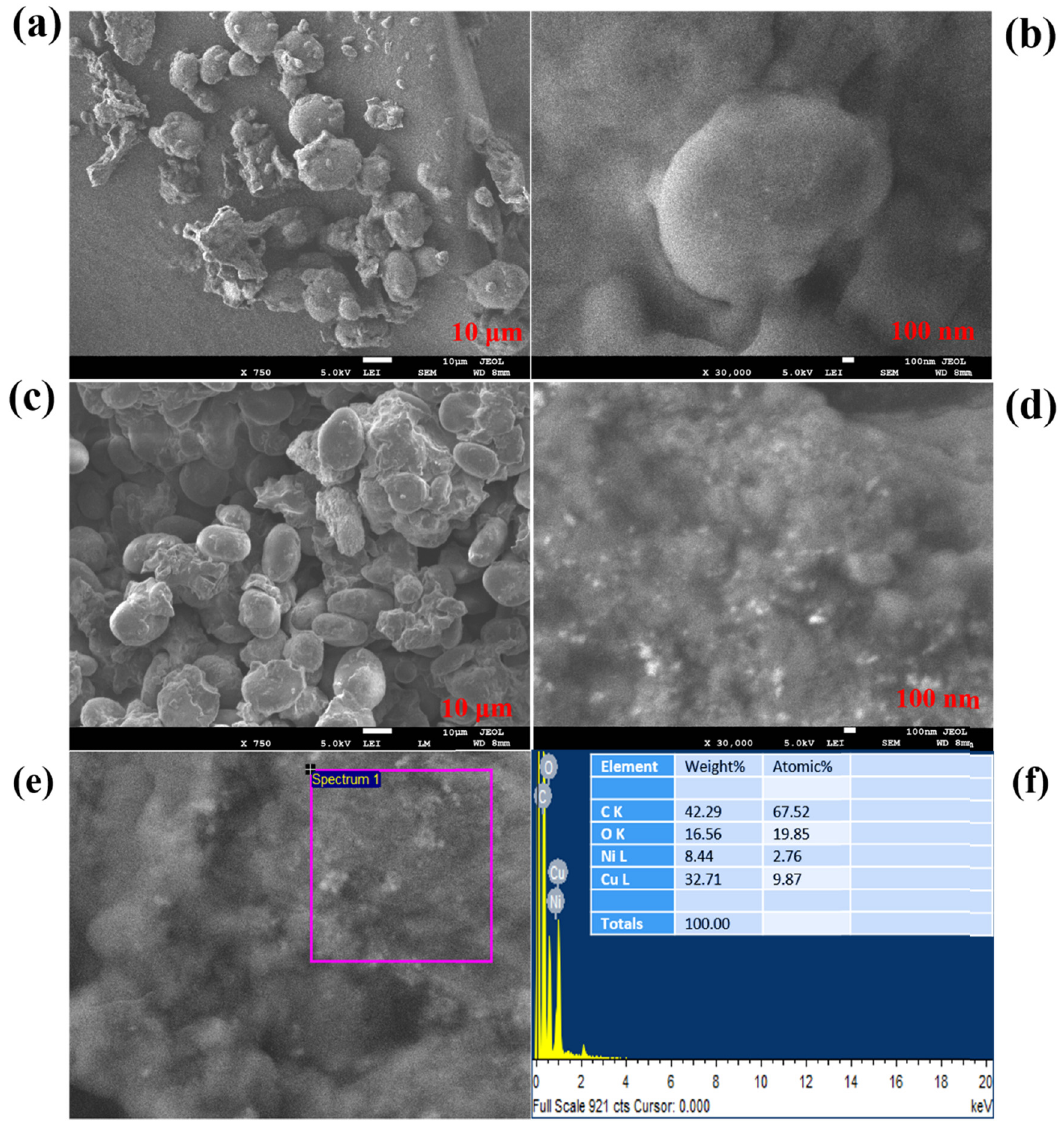
Figure 2: FESEM images of pure CP ( a and b ) and Ni - CP nanoparticles ( c and d ) , the left side images are at low resolutions ( 10 μ m ) , while the right side images are at high resolution ( 100 nm ) . Area selection for EDS spectrogram ( e ) and elemental analysis window ( f ) of CuNi@CP